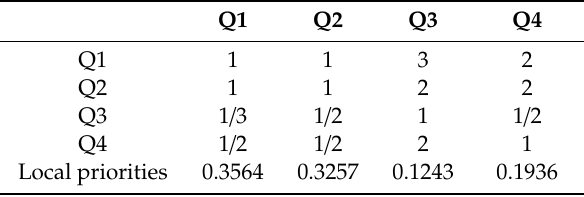
Pairwise comparisons of the criteria in the quality cluster with respect to the long-term relationship. Q1